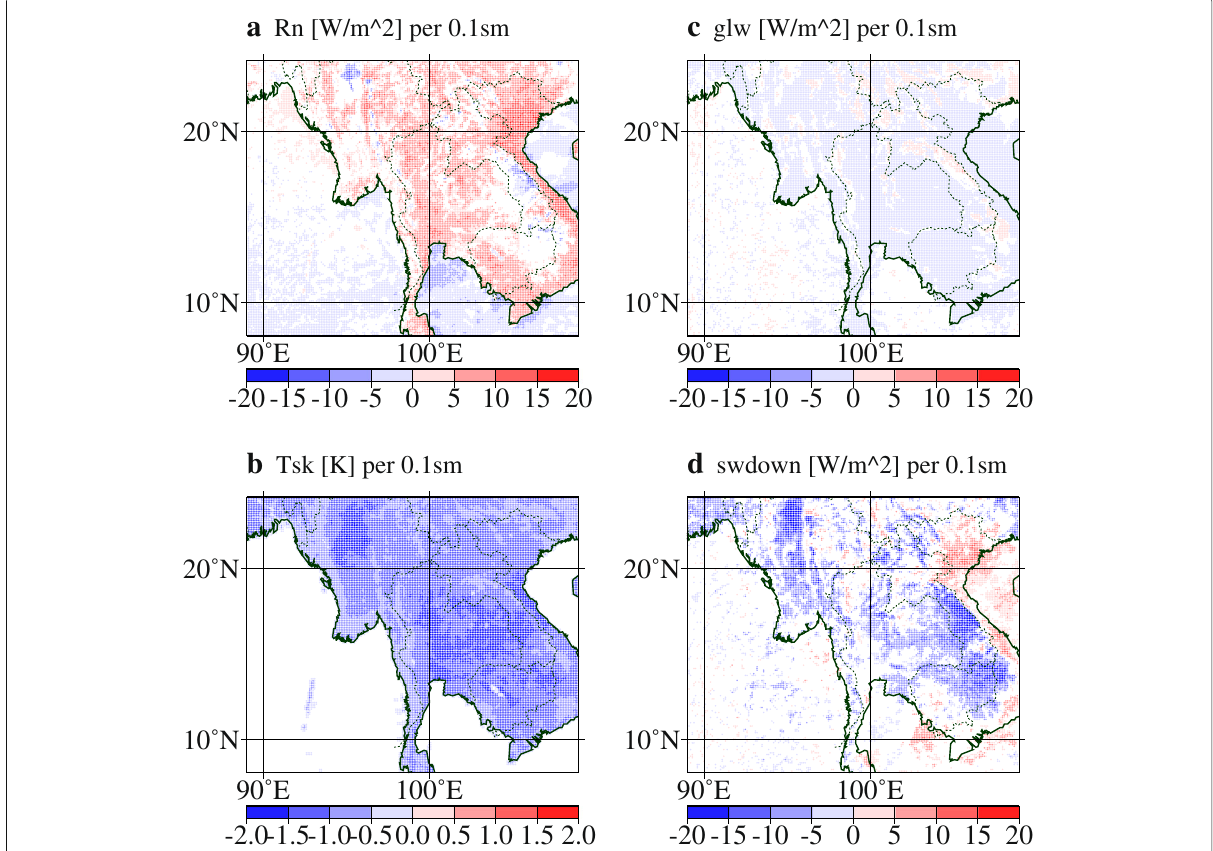
Fig. 7 Same as Fig. 3 but for a net radiation at the surface, b surface skin temperature, c downward longwave radiation at the surface, and d downward shortwave radiation at the surface. The units are W m − 2 per 0.1 increase in soil moisture, K per 0.1 increase in soil moisture, and W m − 2 per 0.1 increase in soil moisture, and W m − 2 per 0.1 increase in soil moisture,